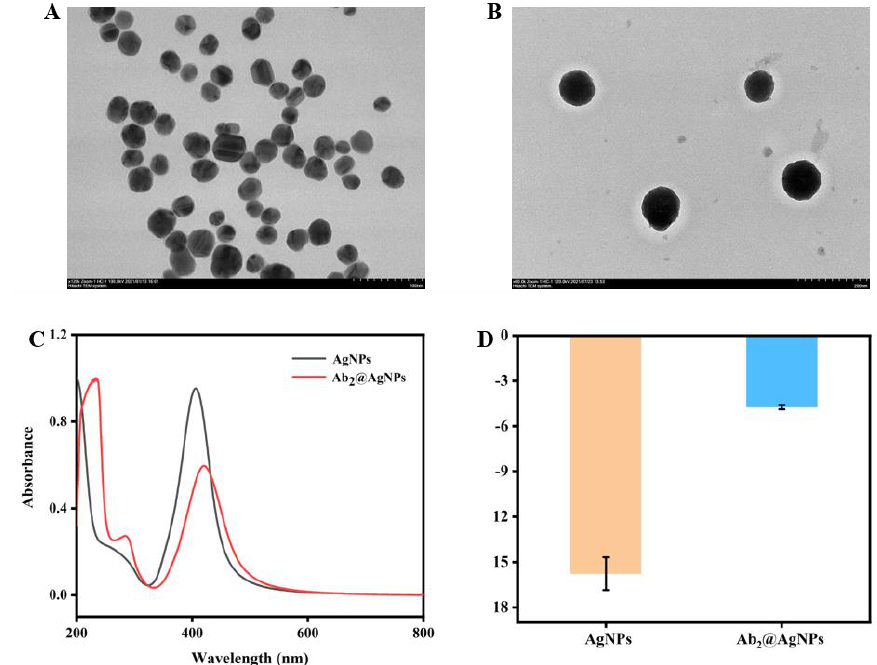
Figure 1. Characterization of AgNPs and Ab 2 @AgNPs. ( A ) Structure and TEM image of AgNPs, ( B ) structure and TEM image of Ab 2 @AgNPs, ( C ) The UV absorption spectra of AgNPs and AgNPs@Ab 2 , and ( D ) The Zeta potential analysis of AgNPs and AgNPs@Ab 2 .